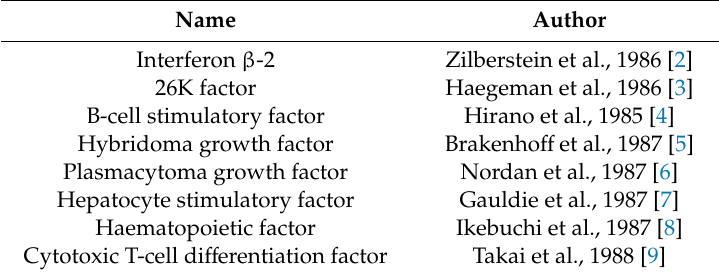
Table 1. Synonyms for interleukin-6 (IL-6).